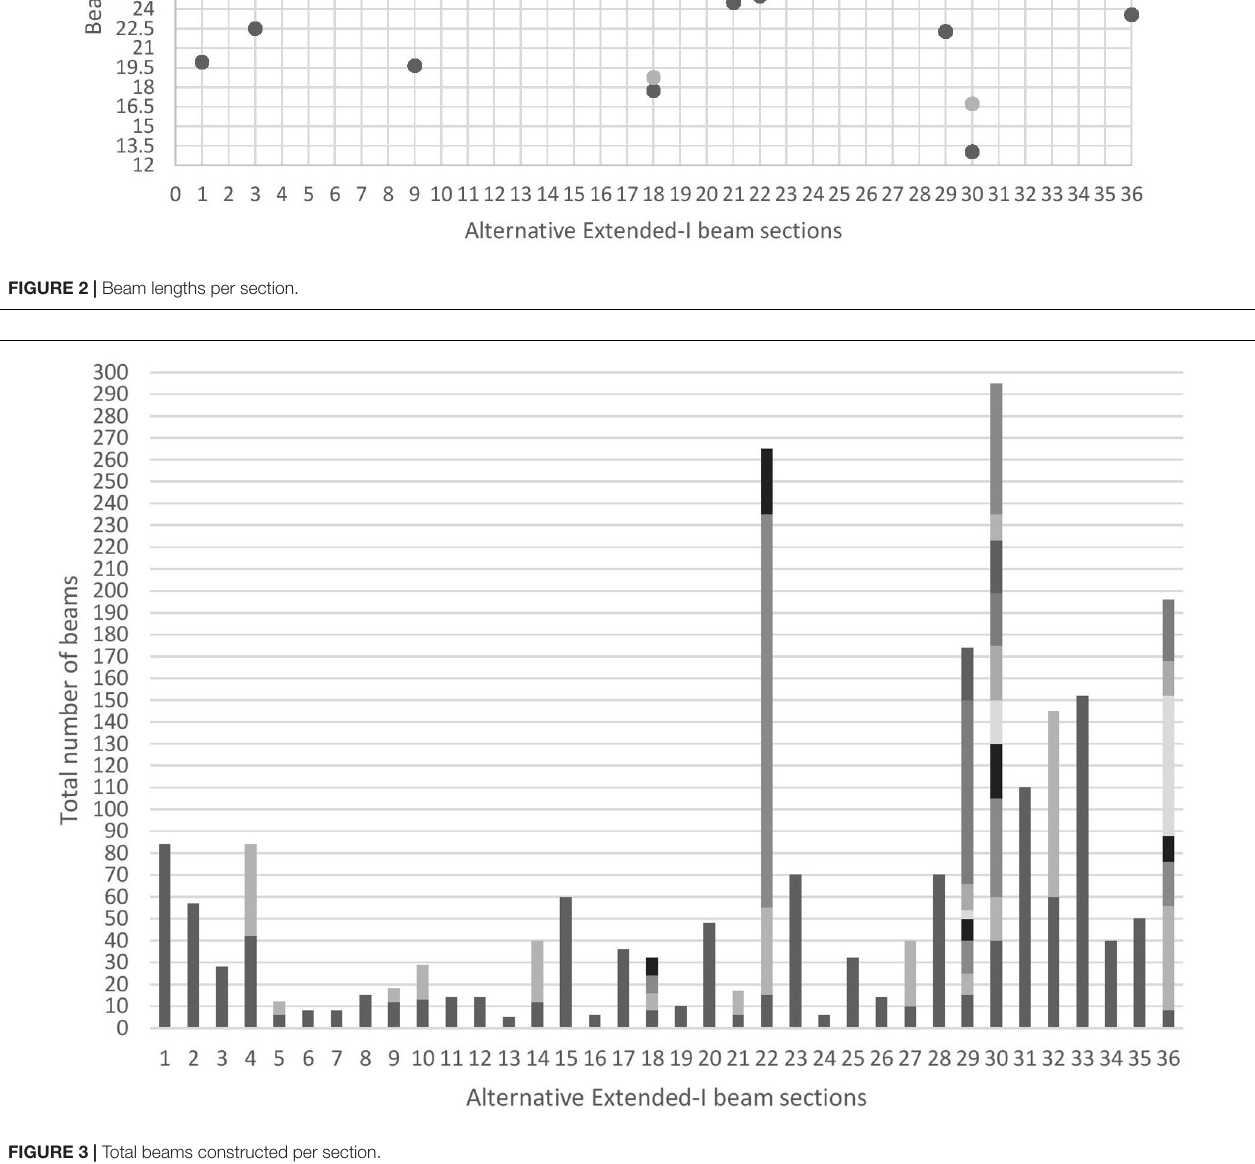
FIGURE 3 | Total beams constructed per